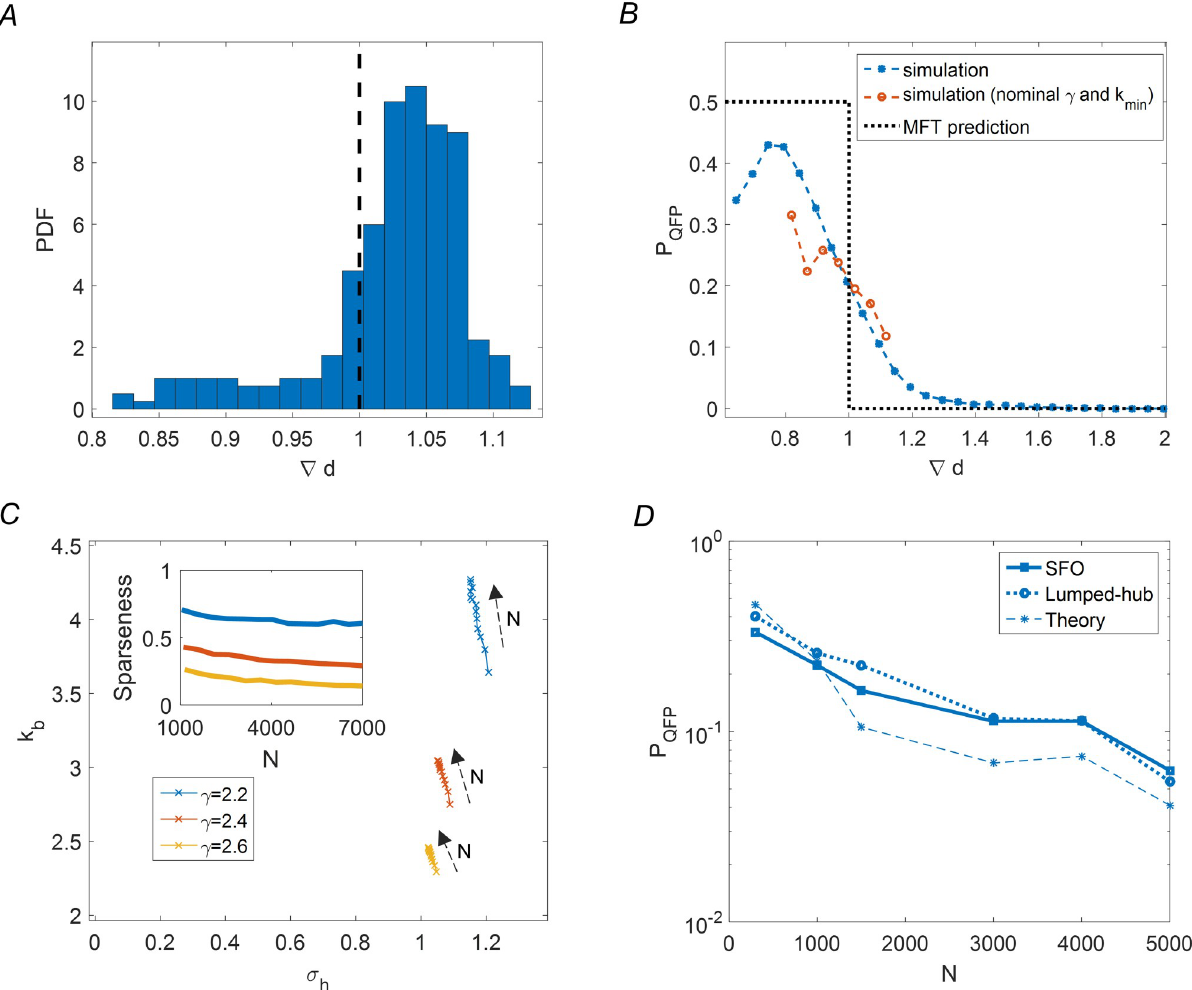
Fig 6. Comparing lumped-hub MFT prediction with SFO simulations. (A) Variability of lumped-hub parameters in a single scale free network ensemble: histogram shows the distribution of r d as computed from the lumped-hub parameters, for a scale free ensemble with γ = 2.4, k = 1. Black min dashed line: MFT predicted phase transition, r d = 1. (B) Transition in convergence probability P QFP (blue symbols) computed for networks with different k min values in range 0.5 � k min � 2 and γ = 2.2, 2.4, 2.6. For each set of parameters 256 network realizations of size N = 1500 were simulated. Results were then binned by r d width of 0.05. Bins with less than ten samples were omitted from the plot (restricting the standard error to 0.16 per point). A short red line shows the data for the single ensemble of panel A. (C) Effect of network size on average lumped hub parameters k , σ h , and α affected most strongly. Colors show (sparseness; inset). Increasing network size causes a gradual shift towards the unstable phase (see Fig 5B), with k b different γ . (D) Effect of network size on convergence probability: comparing simulation, lumped-hub approximation and theory. Empirical data points represent 256 Monte-Carlo realizations for scale free with γ = 2.4, k = 1. min